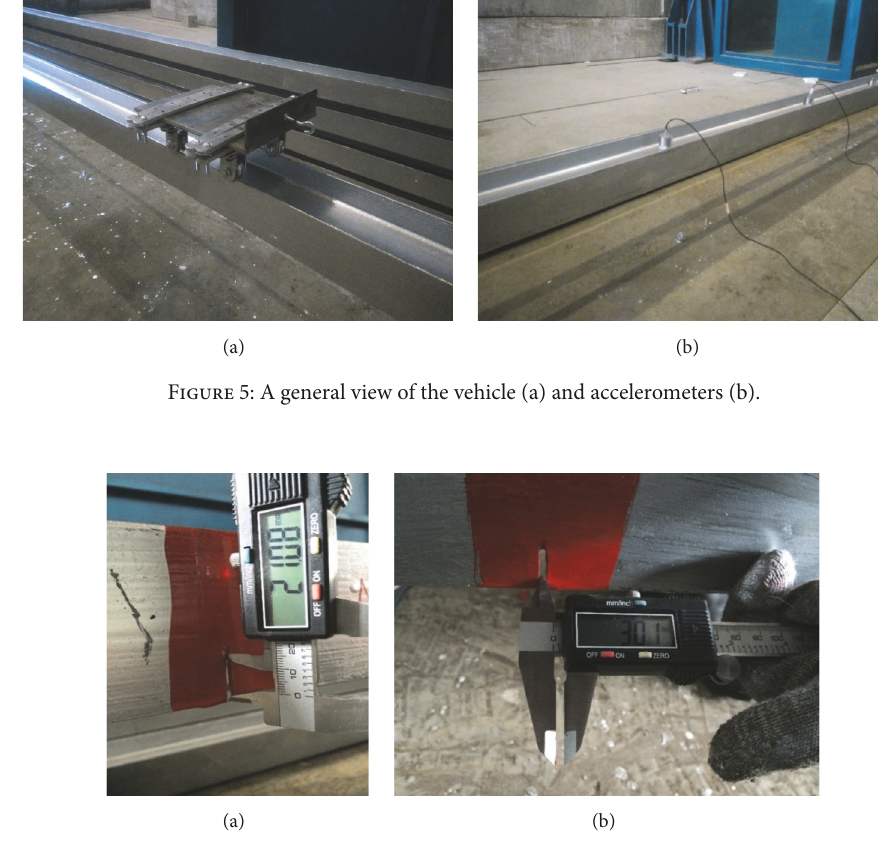
Figure 6: A general view of the crack. (b) shows the width of the crack (around 0.003 m) and (a) shows the height of the crack for delta = 30% (0.072 × 0.3 = 0.0216 m ≈